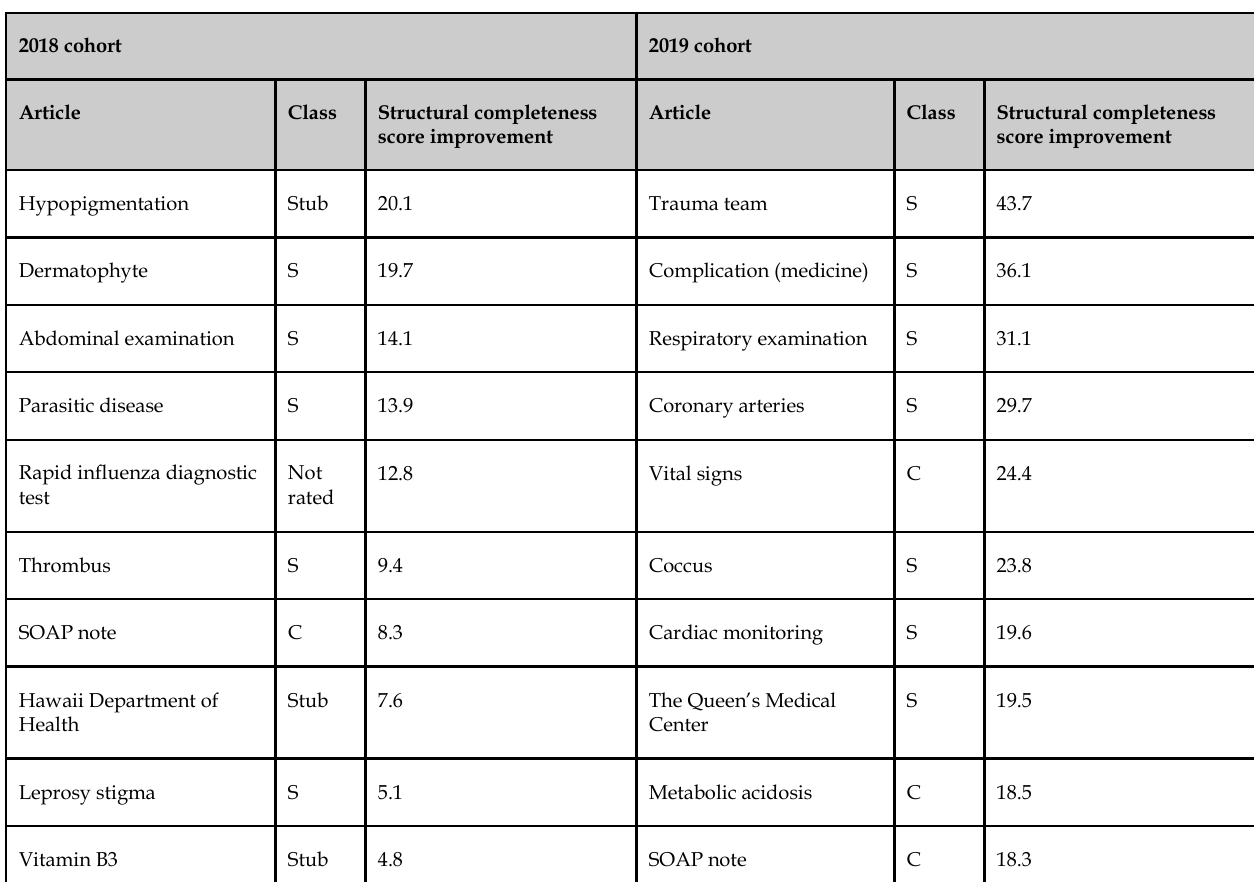
Table 4 Most improved articles by